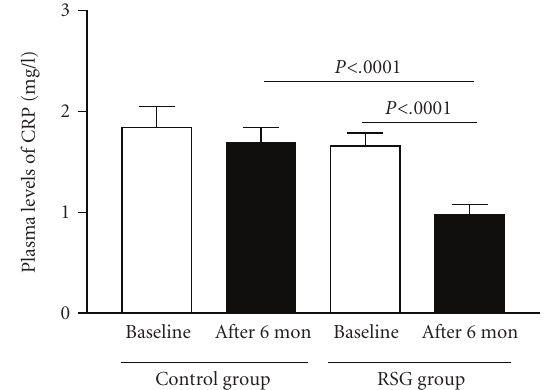
Figure 3: E ff ect of rosiglitazone treatment on plasma levels of C- reactive protein (CRP) in patients with diabetes and coronary artery disease after percutaneous coronary intervention. Data are means ± SD. Control group, n = 56; rosiglitazone (RSG) group, n =